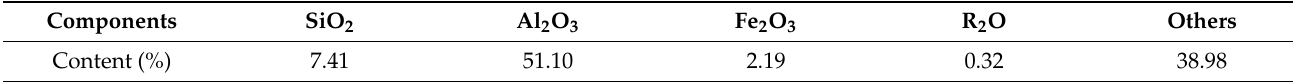
Table 3. Composition of high-alumina